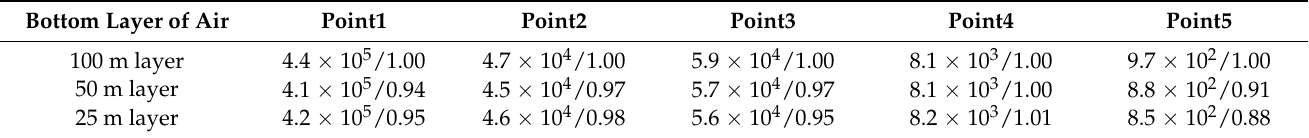
Table 5. Deposit of Cs-137, seven days from the beginning of the release of 1 × 10 15 Bq, in various points, as a function of the height of the bottom layer of air. Dry deposit, [Bq/m 2 ], and ratio to dry deposit in the case of a 100 m layer. Bottom Layer of Air